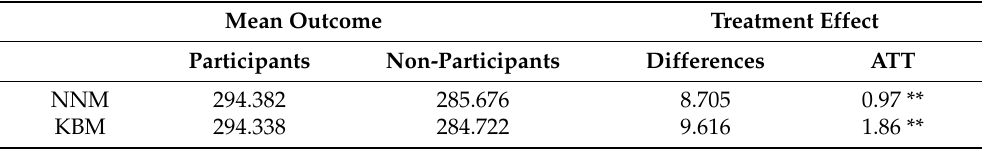
Table 6. PSM Estimations for average treatment effects of FFS participation on citrus